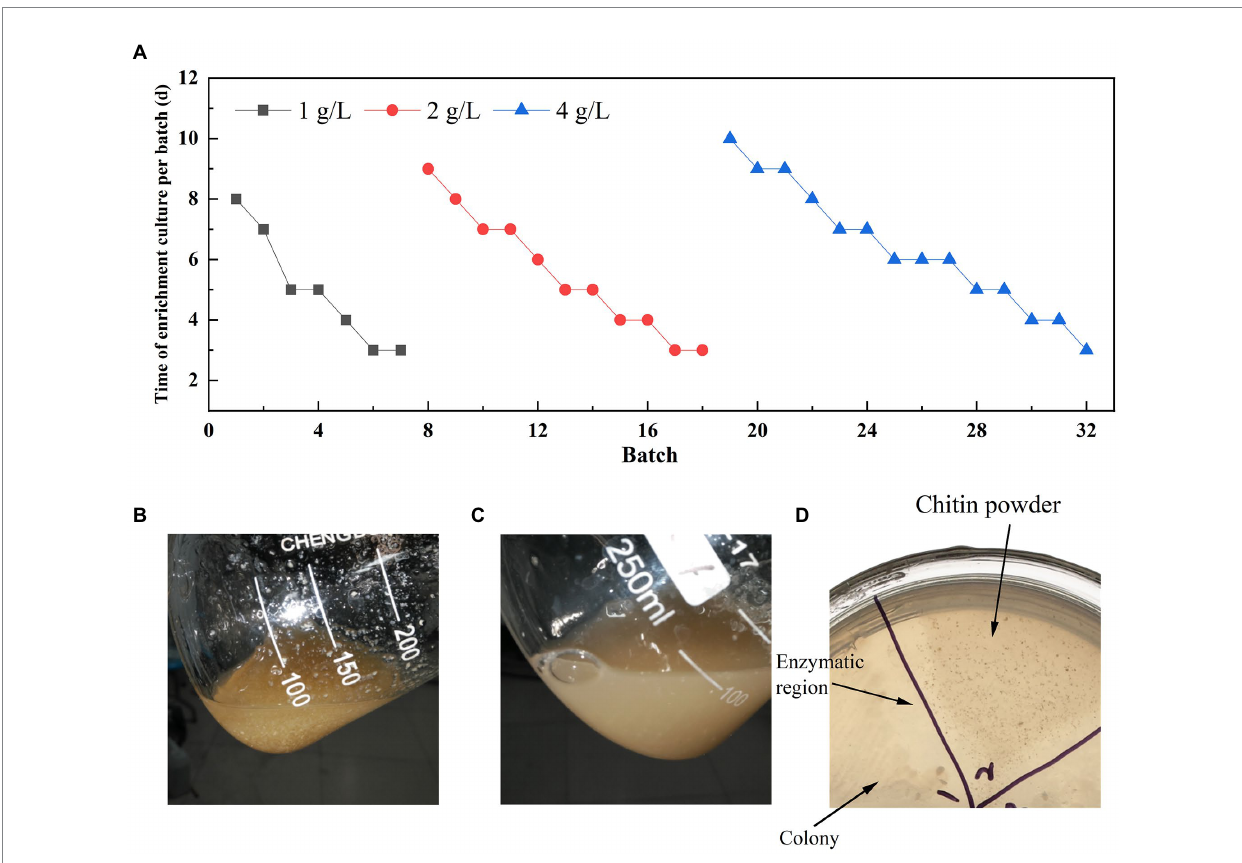
FIGURE 1 Enrichment results of LNM in different concentrations of chitin powder. (A) Time for gradient enrichment in each batch; Appearance state of chitin powder in the fermentation broth of LNM32 before inoculation (B) and after 3 days (C) of fermentation; (D) LNM32 hydrolyzed chitin powder produced clear hydrolyzed area on the agar